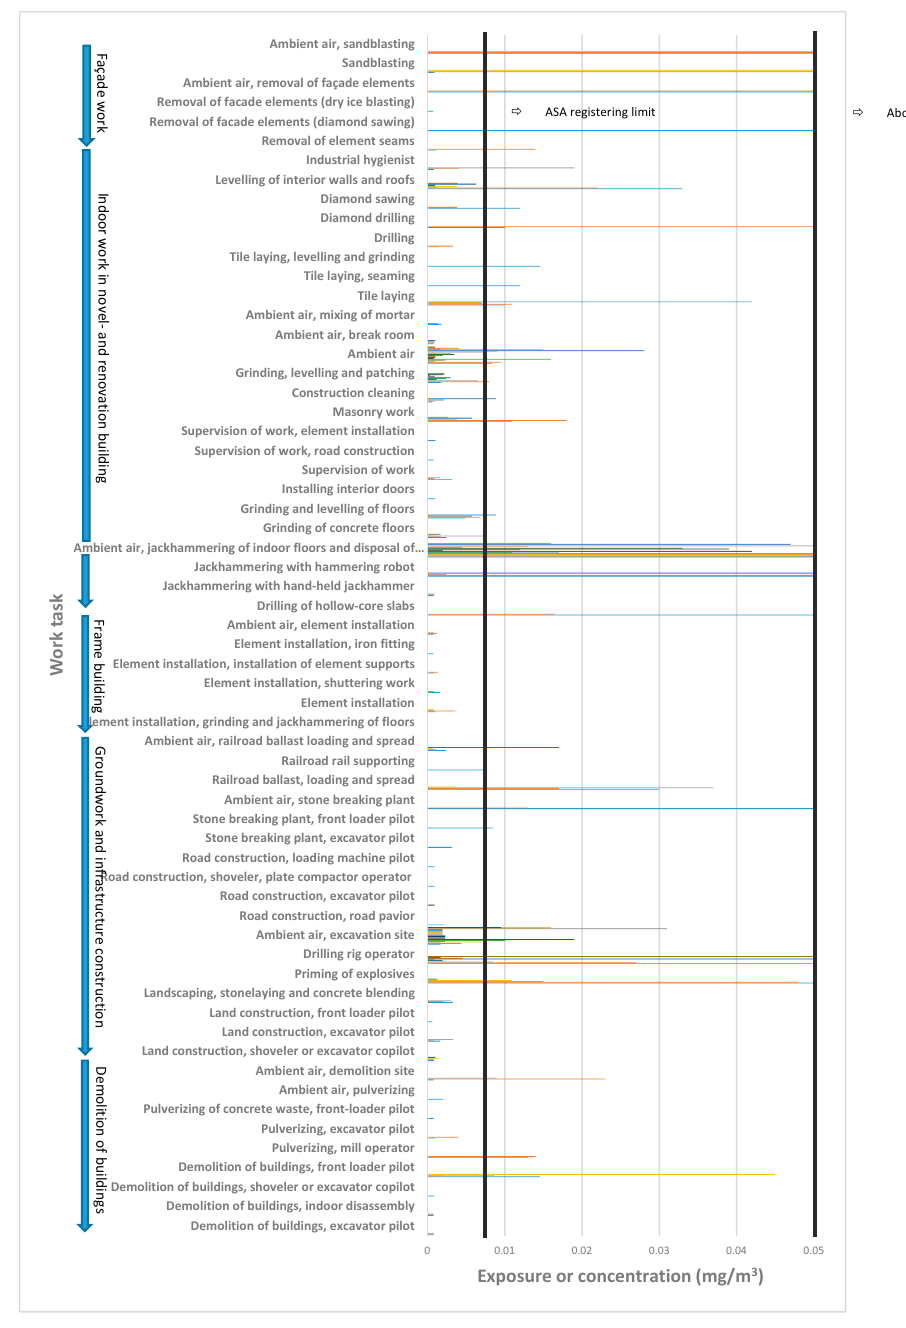
Figure 6. Respirable quartz exposure in work tasks, taking into account respiratory protection. Each colored line represents the estimated exposure of one worker. Reproduced with permission from Tuomi et al., Finnish Institute of Occupational Health, 2022